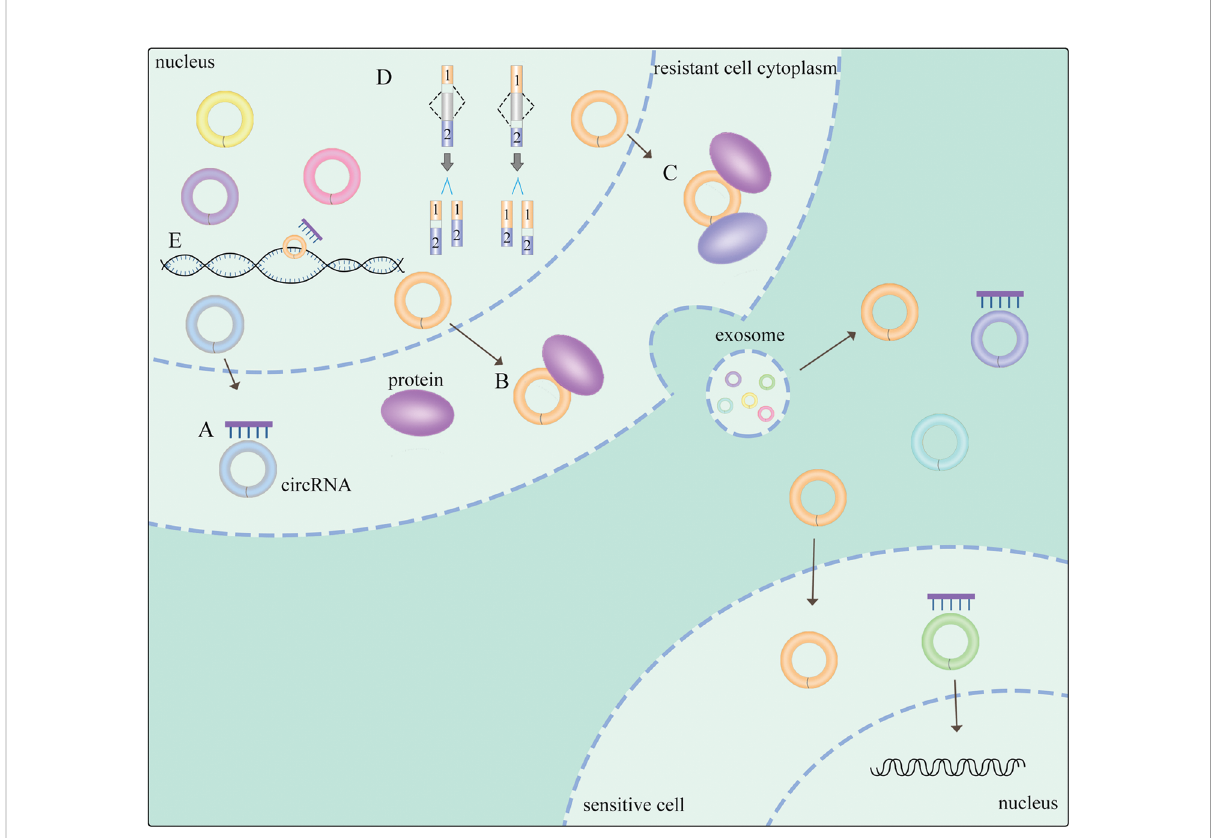
FIGURE 1 General mechanisms of circRNAs functions in NSCLC. (A) circRNAs act as miRNA sponges. (B) circRNA-protein interactions. (C) circRNAs function as protein scaffolding. (D) circRNAs modulate alternative splicing. (E) circRNAs regulate gene transcription. The meaning of " → " is